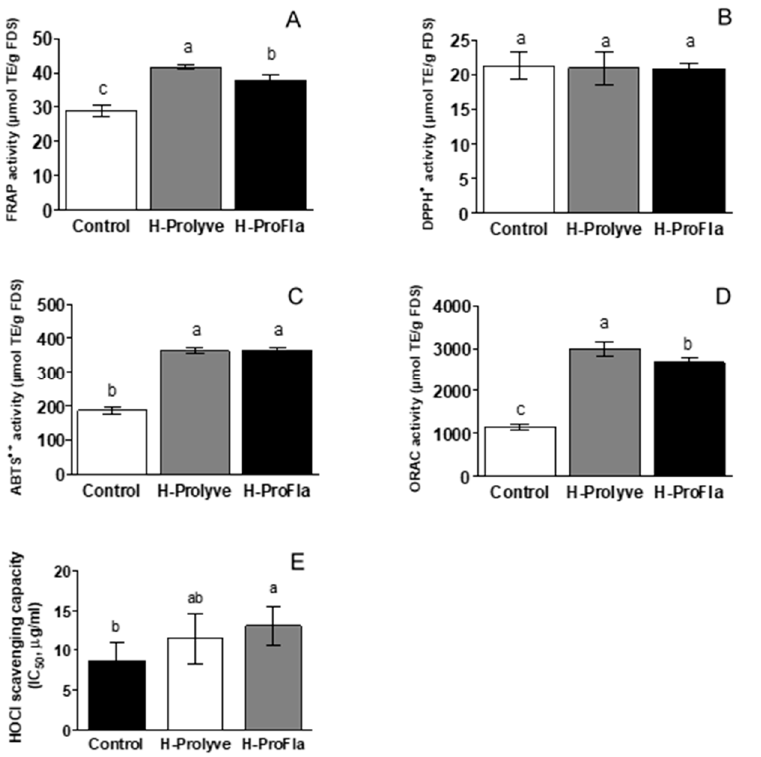
Figure 4. ( A ) Ferric reducing activity power (FRAP), ( B ) 2,2-Diphenyl-1-picrylhydrazyl (DPPH • ) scavenging activity, ( C ) 2,2 ′ -Azinobis-(3-ethylbenzothiazoline-6-sulfonate (ABTS •+ ) scavenging capacity, ( D ) Oxygen radical absorbance capacity (ORAC) and (E) Hypochlorous acid (HOCl) scavenging capacity of P. dioica conchocelis, following 2 h hydrolysis at 50 °C with Prolyve (H- Prolyve), and 4 h hydrolysis with Prolyve plus Flavourzyme (H-ProFla). Values represent mean ± SD ( n = 3). Results expressed as μ mol of Trolox equivalents (TE) per g of freeze-dried sample ( μ mol TE/g FDS). IC 50 = inhibitory concentration, in vitro , to decrease by 50% the effect of the reactive species in the tested media ( μ g FDS/mL). Different letters denote significant differences at p <